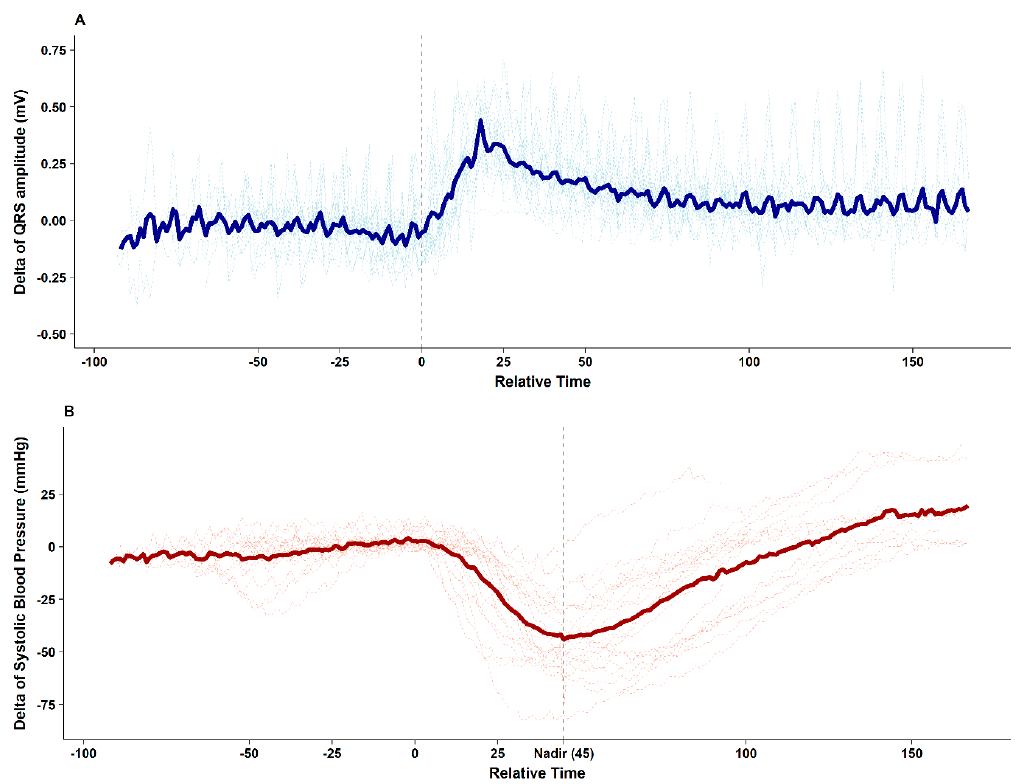
Figure 2. Delta changes from baseline of the QRS R-amplitude ( A ) and systolic blood pressure ( B ) after the injection of contrast agent during mobile computed tomography in all enrolled patients. An increase in the QRS R-amplitude (median 0.43 mV) is observed 25 ± 10 seconds before nadir systolic blood pressure. The median decrease in systolic blood pressure is 53 mmHg, which recovers to baseline level after 63 ± 19 seconds. The thick line indicates the mean value. After contrast media injection, significant QRS R-amplitude augmentation (median of delta changes 0.43 mV, median 22% increase from baseline) was observed 25.2 ± 10.3 seconds before profound hypotension. The median decrease in SBP from baseline was 53 mmHg (median 40% decrease from baseline), which recovered after 62.7 ± 19.2 seconds. ROC curve analysis showed that 16% QRS R-amplitude augmentation from the baseline ECG can predict SBP drop > 25% with an AUC of 0.852 (95% confidence interval 0.774–0.929, p < 0.001), sensitivity of 71.1%, and specificity of 87.5%, whereas changes in the ST height (AUC 0.614) and R–R interval (AUC 0.687) were not significant during hypotension (Figure 3).